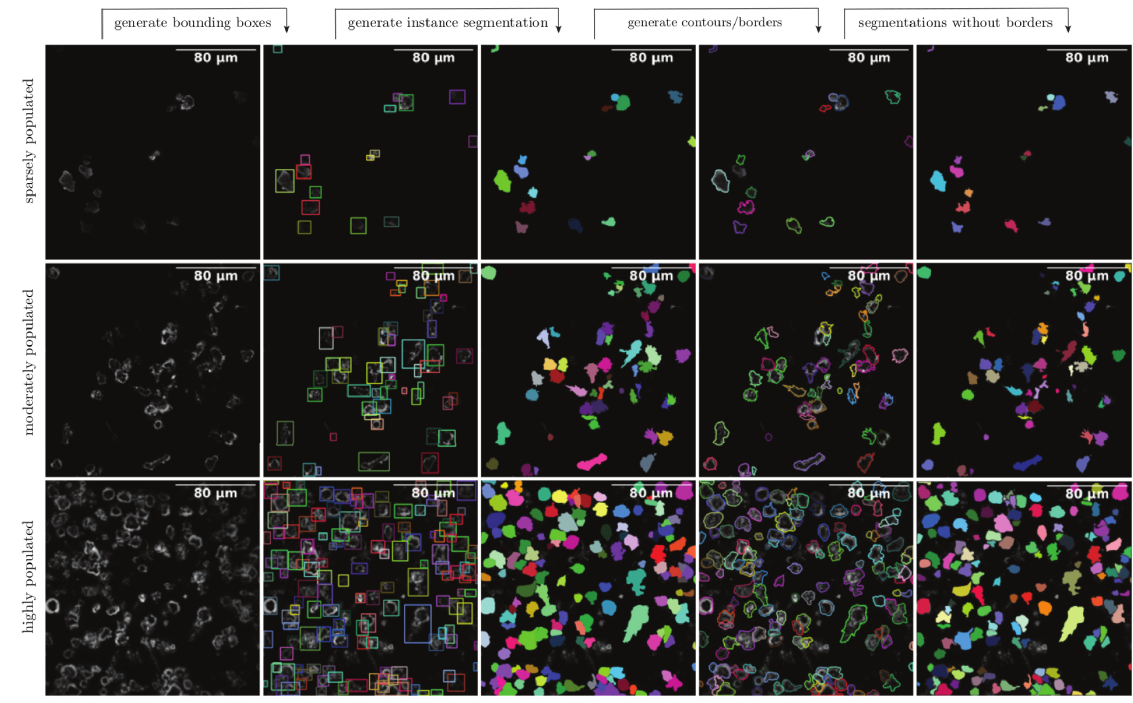
Fig 8. The outputs of multi-scale cell instance segmentation. For illustration, we use three different images in three different rows. The first row is for a sparsely populated image, the second row is for a moderately populated image, and the third row is for a highly populated image. The framework contains two modules: (a) bounding box detection module and (b) individual cell segmentation module. The bounding box detection outputs the bounding boxes over each detected cell. The bounding box determines an object by indicating the top-left, top-right, bottom-left, bottom-right, and center points, respectively. The bounding boxes are used to create patches of cells, used for instance segmentation. The instance segmentation masks can be used to create borders (contours) and segmentations without borders, which are inside the areas of the segmented